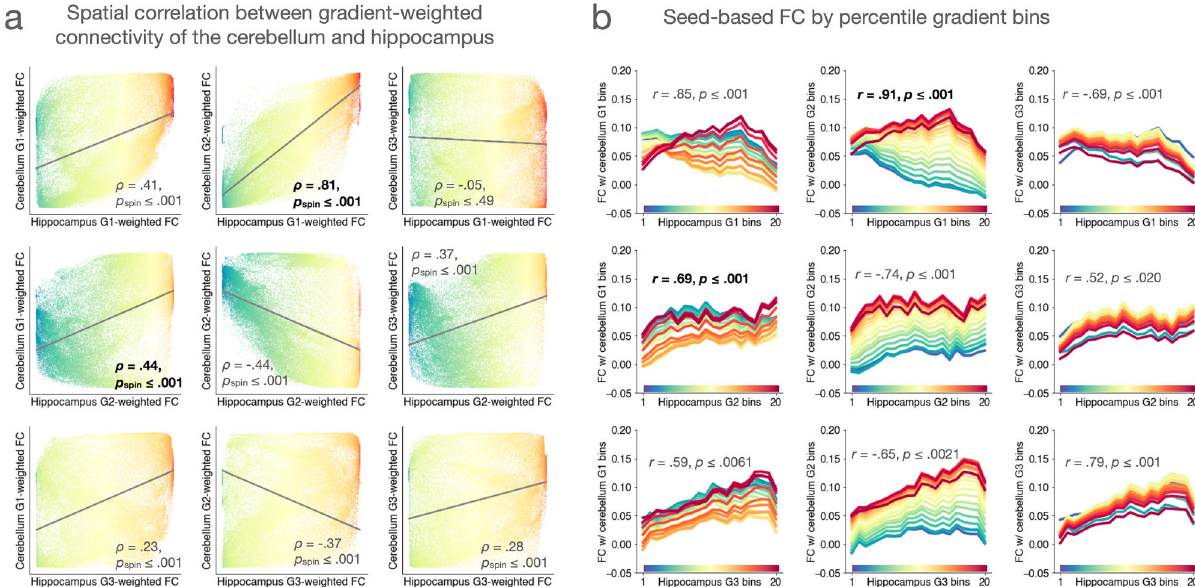
Fig. 3 Correspondence between cerebellar and hippocampal functional connectivity gradients in relation to the isocortex. a Each panel represents the spatial association between gradient-weighted functional connectivity maps of the cerebellum and hippocampus (see Fig. 2a). b Results of seed-based functional connectivity analysis based on gradient bins in a given pair of cerebellar and hippocampal functional connectivity gradients in relation to the isocortex. All p values are based on two-sided hypothesis testing. For each non-isocortical gradient, the strongest correlation is shown in bold